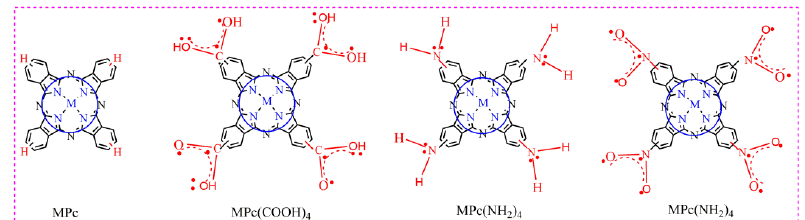
Figure 6. Conjugate effect of phthalocyanine structures.